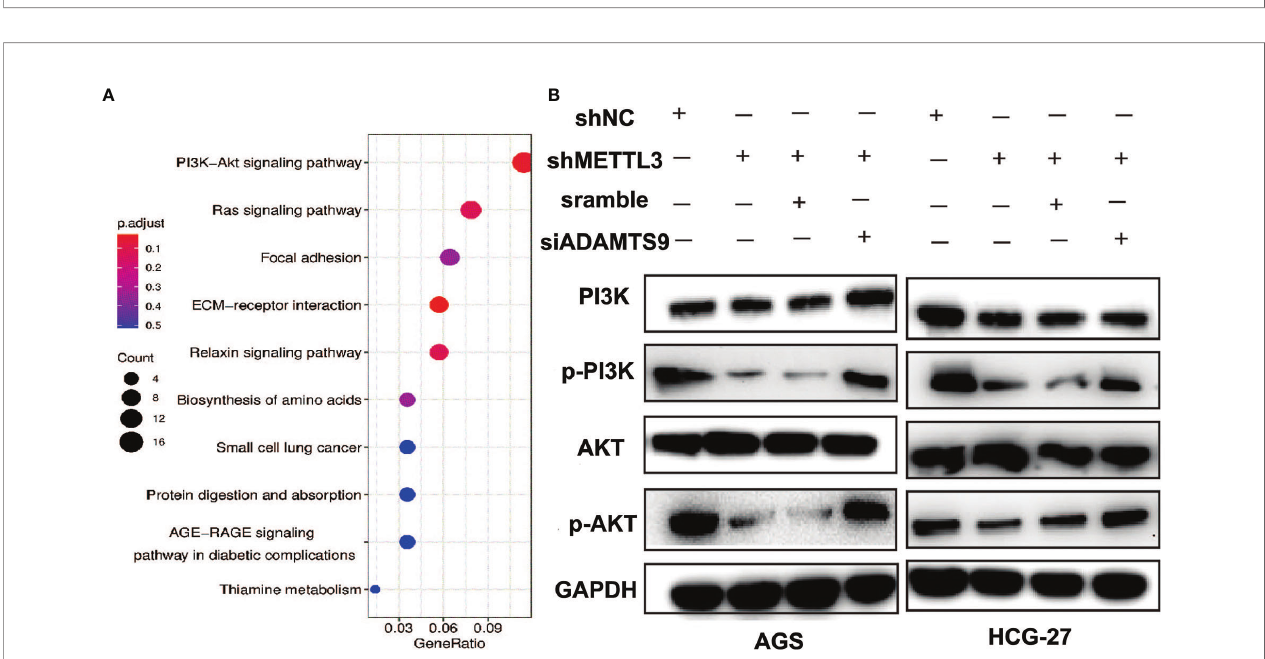
FIGURE 6 | ADAMTS9 reversed the effects of METTL3 in GC. (A) The ADAMTS9 expressions were arti fi cially reduced in METTL3 knockdown GC cells. (B) The cell viability of METTL3-knockdown GC cells was detected after ADAMTS9 suppression by CCK-8 assay. (C) The proliferation of METTL3-knockdown GC cells were detected after ADAMTS9 suppression by colony formation assay. (D) The angiogenesis ability of METTL3-knockdown GC cells were evaluated after ADAMTS9 suppression by tube formation assay. Scar bar = 50 m m, **P < 0.01, ***P < 0.001.